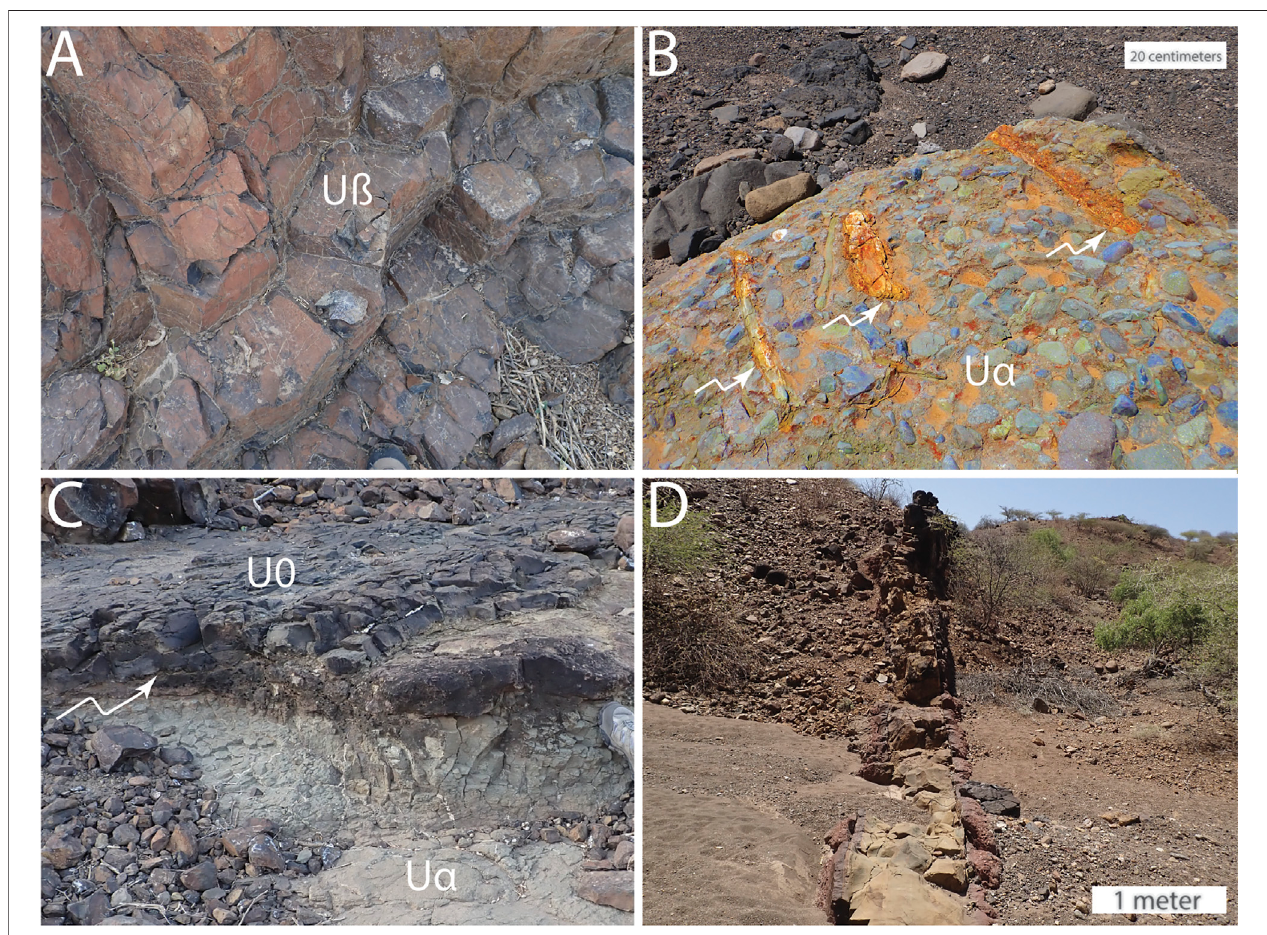
FIGURE 3 | Four fi eld photos from the study area. (A) Columnar jointed basalt of new basal unit Uß (20TB23). Toe box of boot for scale at bottom of image. Location: 3.853661 ° N, 35.715842 ° E. (B) Conglomerate in unit U α . Clasts are predominantly of weathered ma fi c volcaniclastic composition. White arrows point to chunks of fossil wood. Colors are enhanced to increase visibility of clasts and contrast with alluvium in background. Location: 3.853731 ° N, 35.718022 ° E. (C) New discovery of conformable base of unit U0 on unit U α . White arrow points to conformable contact. Toe box of boot for scale at right side of image. Location: 3.853398 ° N,35.719134 ° E.Fordetailedlocationofphotosin (A – C) , Figure4 caption. (D) Ma fi cdikecuttingthroughTopernawiFormation.Locationshownon Figure1 (3.860148 ° N, 35.725909 ° E).